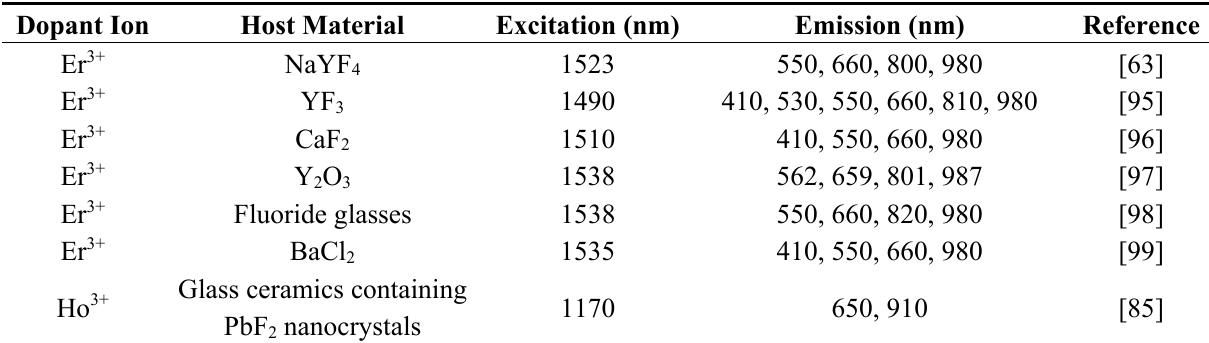
Table 2. Typical dopant ions, the main emissions, and the corresponding energy transitions for upconversion nanocrystals reported in the